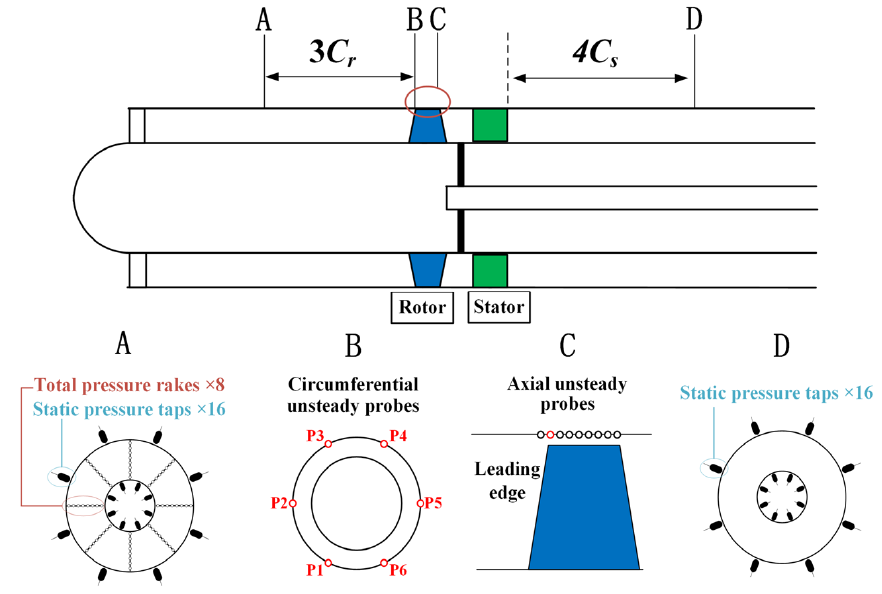
Figure 2. Steady and unsteady measurement layout.